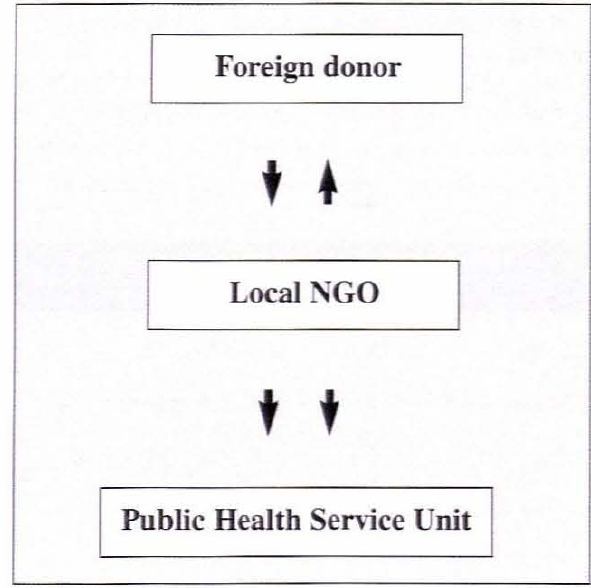
Fig. 1. A parrnership ra deliver HAART in rhe public